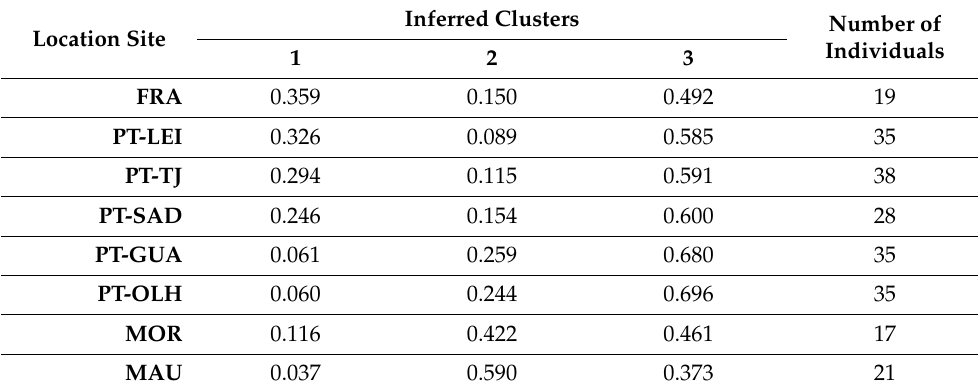
Figure 2. Argyrosomus regius most likely Atlantic population structure, computed under the admixture model with correlated allelic frequencies in STRUCTURE. Each individual is represented by a vertical bar broken into three different colors (orange, yellow, and blue) based on the assignment into inferred clusters (K = 3). Location site and spawning area of each group of individuals is identified in the figure. For location sites’ acronyms, please check Table 1. Table 5. Proportion of membership of each Argyrosomus regius location site in each of the three inferred clusters from STRUCTURE analysis. For location sites’ acronyms, please check Table 1 .